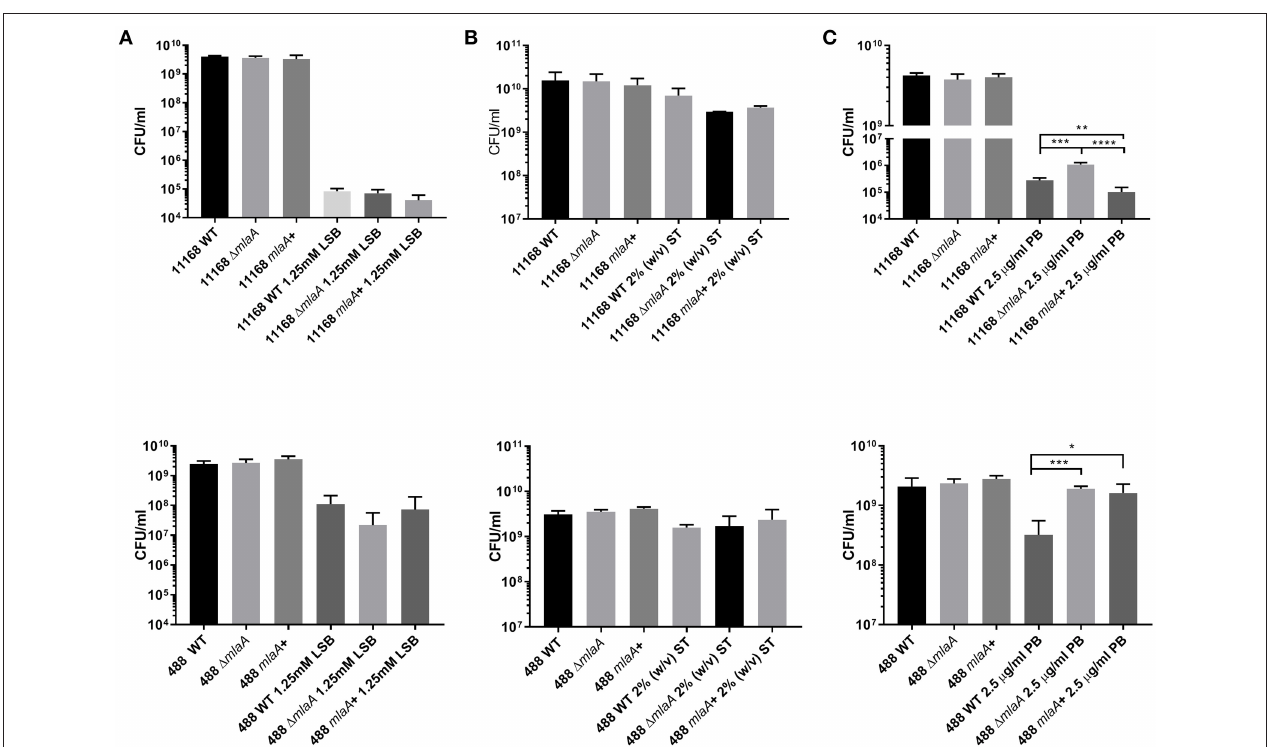
FIGURE 3 | Survival of C. jejuni strains exposed to detergent stress or detergent-like stress. (A) Mid-log phase cultures spotted onto Brucella agar in the presence or absence of 1.25mM lauryl sulfobetaine. (B) Late-log phase cultures grown in Brucella broth in the presence or absence of 2% (w/v) sodium taurocholate. (C) Mid-log phase cultures spotted onto blood agar in the presence or absence of 2.5 µ g/ml polymyxin B. * p < 0.05; ** p < 0.01; *** p < 0.001; **** p <